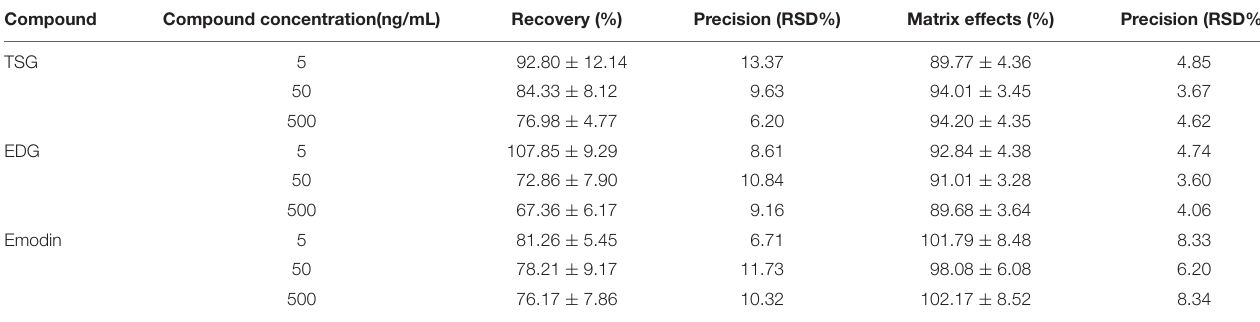
TABLE 4 | Recoveries and matrix effects of TSG, EDG, and emodin. Compound Compound concentration(ng/mL)